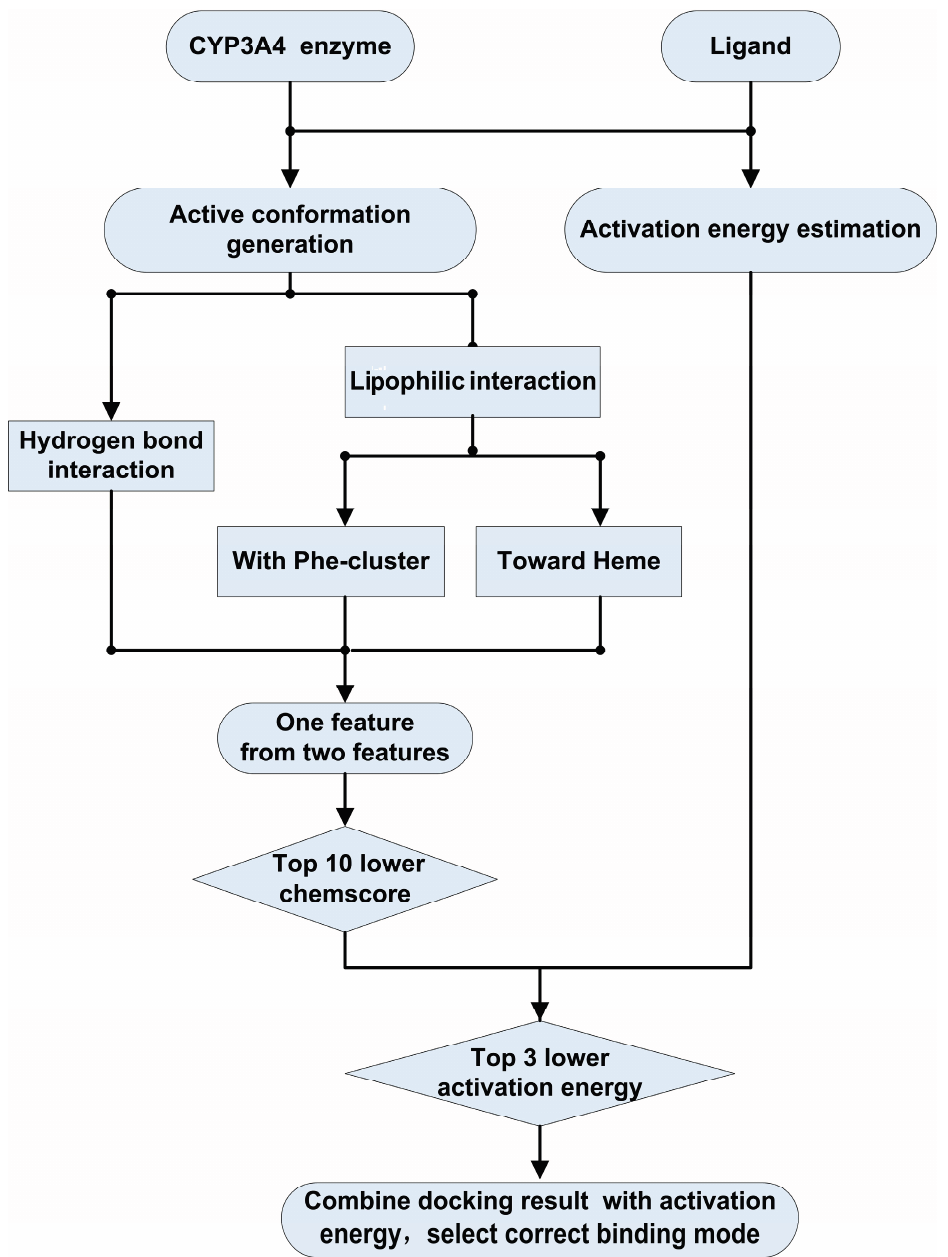
Figure 4. The workflow of the mechanism-based prediction